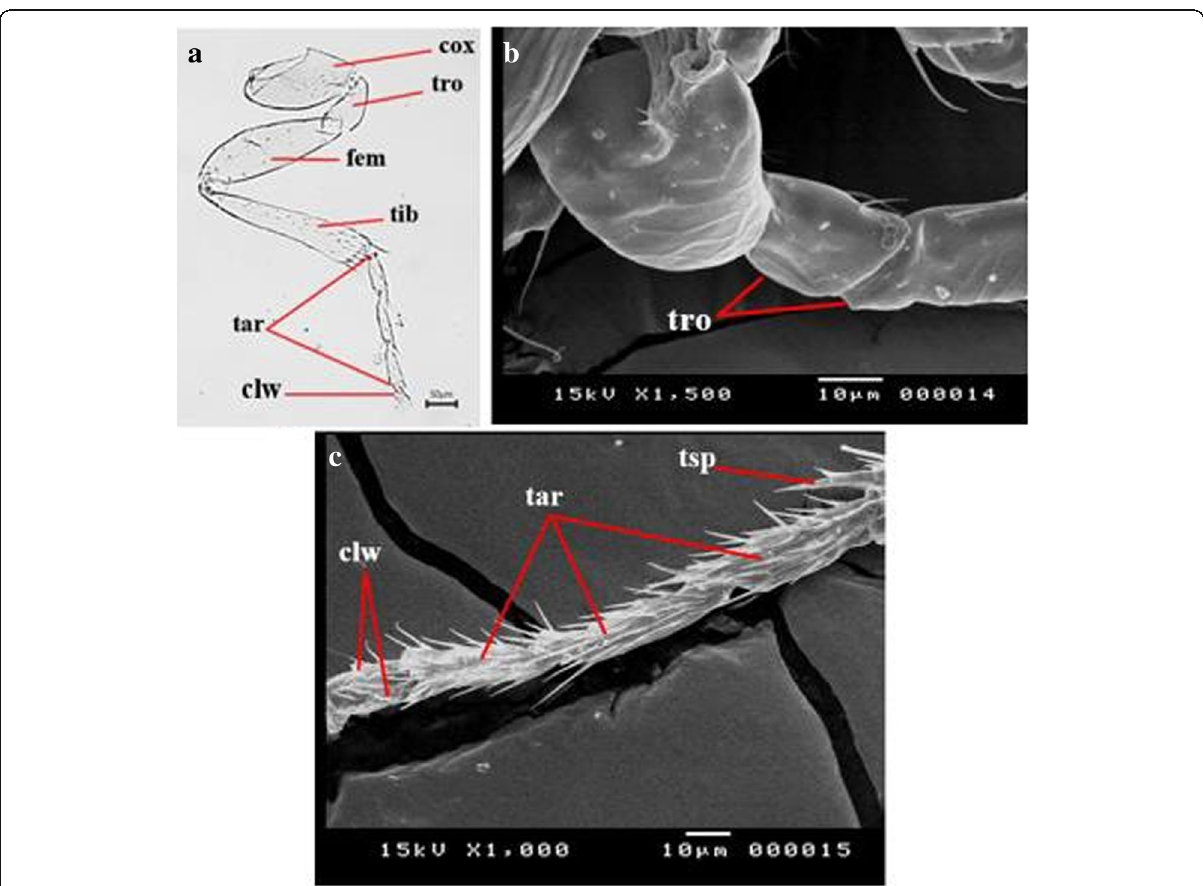
Fig. 6 a light micrograph Trichogramma strain TNV leg ( cox coxa, tro trochanter, fem femur, tib tibia, tar tarsus and clw claw). b SEM tro trochanter (2 segment). c SEM tsp tibial spur, tar tarsus (3 segment) and clw claw (2